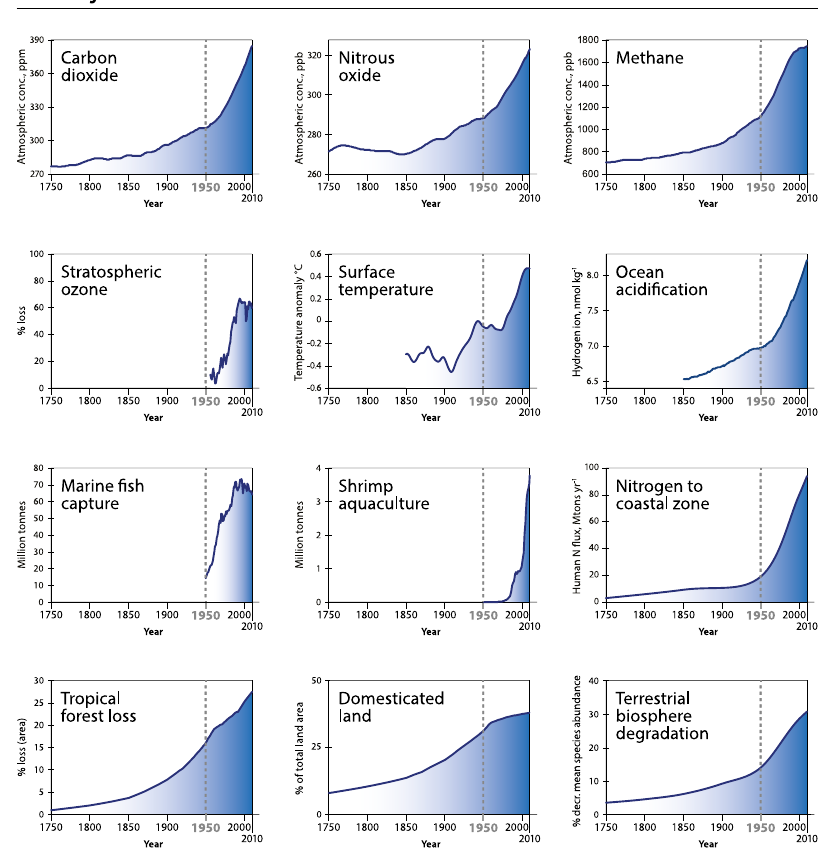
Figure 2. The Great Acceleration, impacts on Nature, courtesy Will